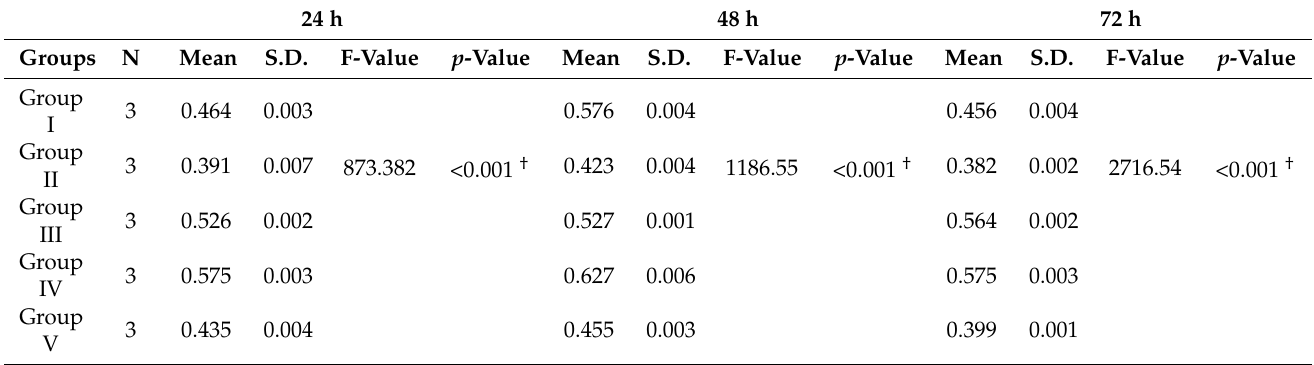
Table 2. Comparison of MTT assay results at 24, 48, and 72 h among the groups.